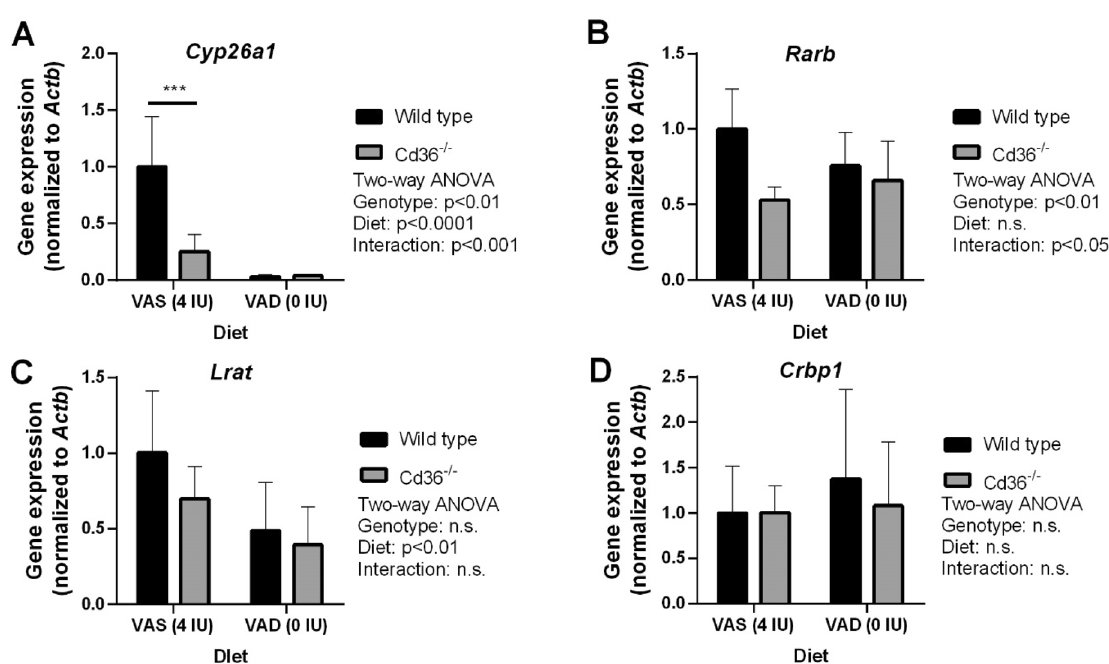
Figure 4. Hepatic gene expression levels of key mediators of vitamin A metabolism in wild type and Cd36 −/− mice on diets with varying vitamin A content. qPCR was used to determine relative hepatic gene expression levels of ( A ) Cyp26a1 , ( B ) Rarb , ( C ) Lrat , ( D ) Crbp1 . Data is shown as mean ± S.D. and significance determined by two-way ANOVA (n = 6 per group). *p < 0.05 denotes a significant post-test result between genotypes within mice of the same